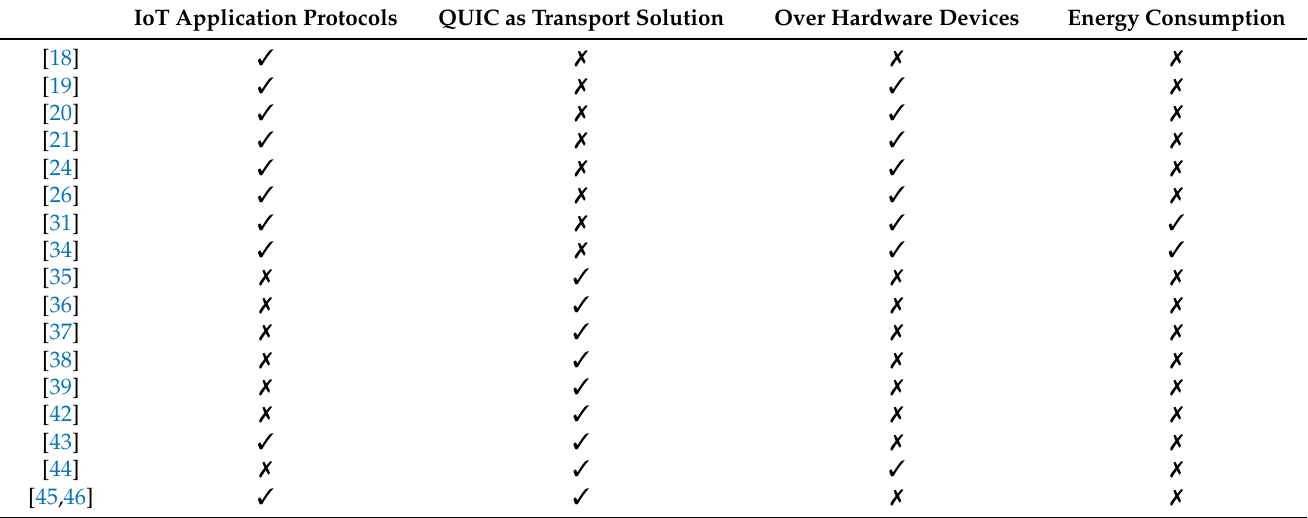
Table 1. Features covered by the related